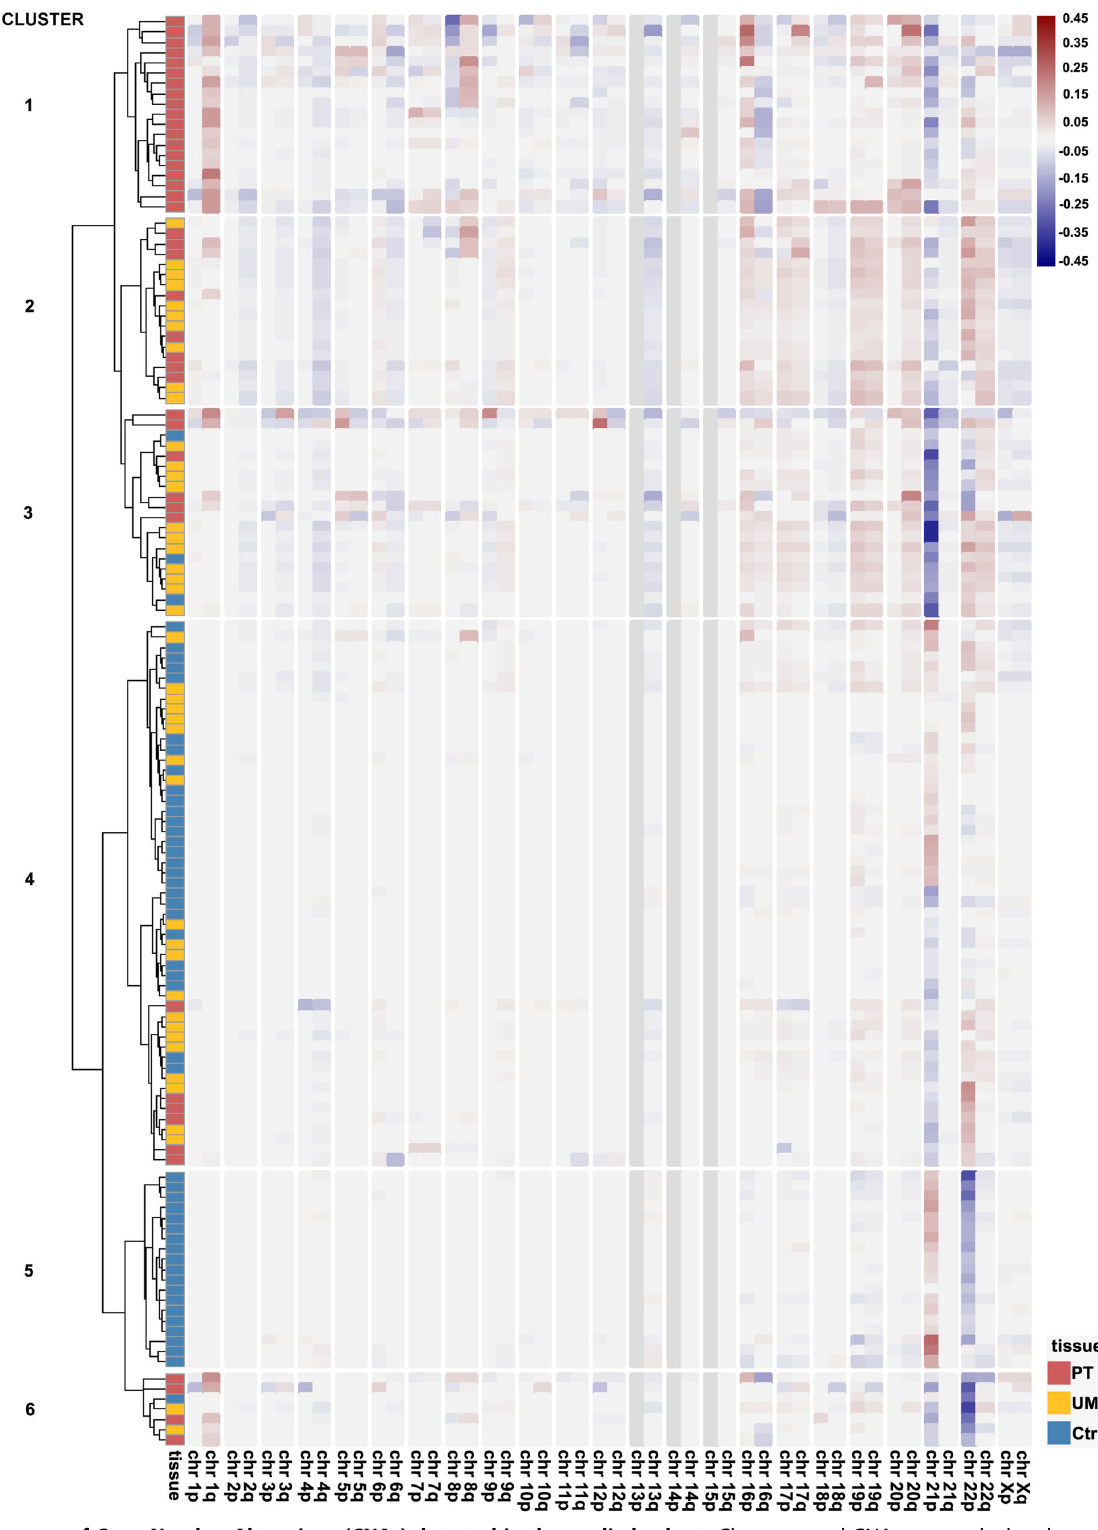
Fig. 1 Summary of Copy Number Alterations (CNAs) detected in the studied cohort. Chromosomal CNAs were calculated as mean Log R Ratio (LRR) for chromosome arm and normalized to mean LRR of a sample. Results are presented as a heatmap with colors indicating gains (positive LRR values; red) and deletions (negative LRR values; blue). Hierarchical clustering was performed with Ward2 algorithm 45 and identi fi ed six clusters. Pie charts with proportion of samples within clusters are presented in the Supplementary Fig. 3. Ctrl control